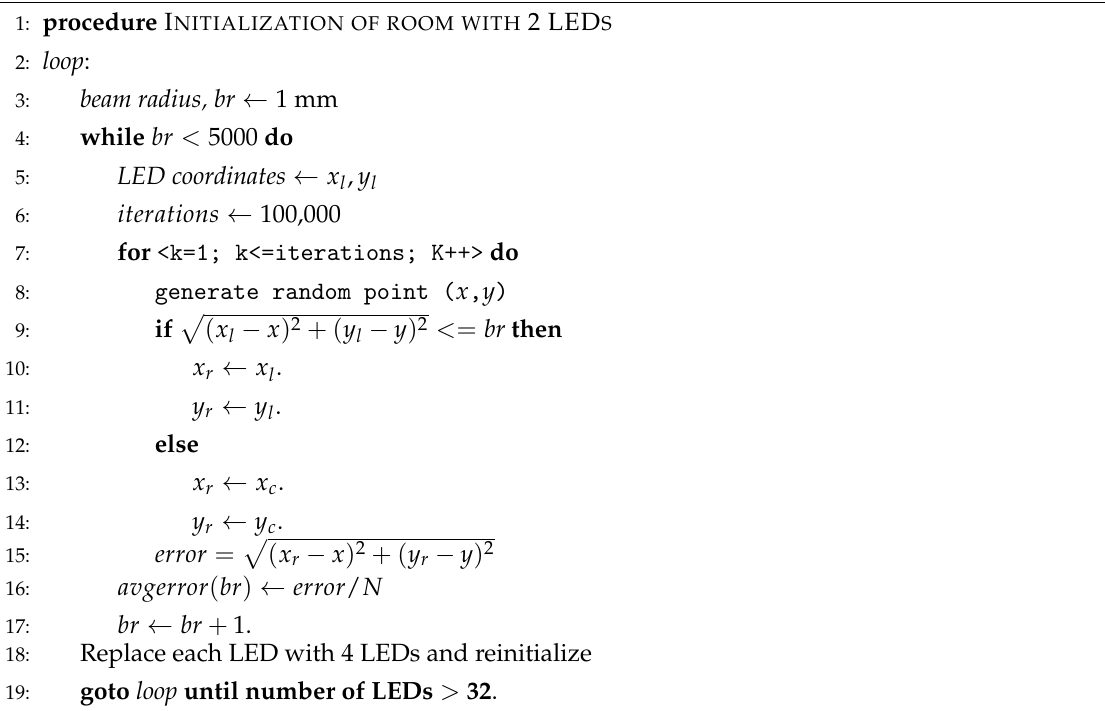
Algorithm 1 Computation of positioning error.